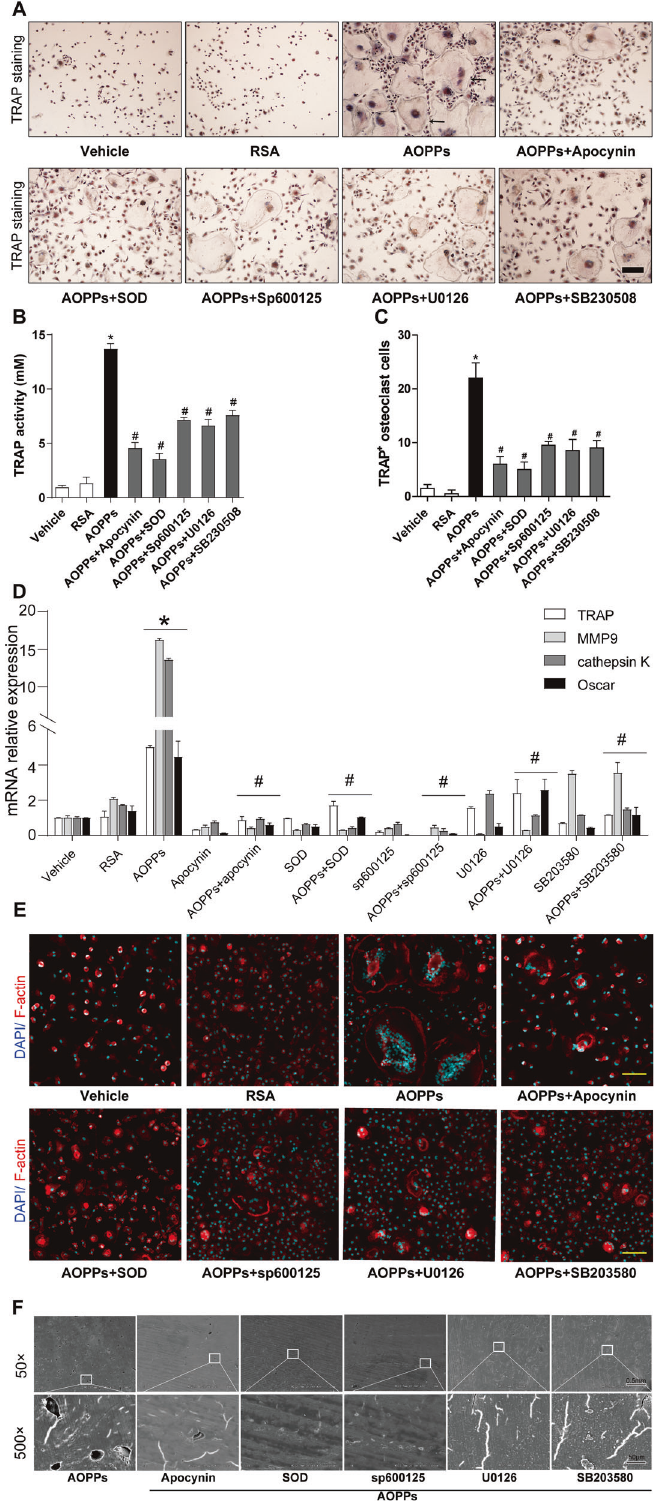
Fig. 7 AOPPs induced osteoclastogenesis through the NADPH oxidase – mediated redox signaling. A , B Apocynin (NADPH oxidase inhibitor), SOD, SP600125 (JNK inhibitor), U0126 (ERK1/2 inhibitor), and SB20358 (p38 inhibitor) suppressed the formation of TRAP positive Osteoclast induced by AOPPs. Scale bars = 200 μ m. C Apocynin, SOD, SP600125, U0126, and SB20358 decreased the TRAP activity. D Blocked of apocynin, SOD, SP600125, U0126, and SB20358 inhibited gene expression of TRAP, MMP9, cathepsin K, and Oscar. E Blocked of apocynin, SOD, SP600125, U0126, and SB20358 inhibited the formation of F-actin rings induced by AOPPs. Scale bars = 100 μ m. F Apocynin, SOD, SP600125, U0126, and SB20358 blocked AOPPs-induced bone resorption. Data were presented as mean ± SD. * p < 0.05 versus the vehicle- treated group; # p < 0.05 versus AOPPs group.